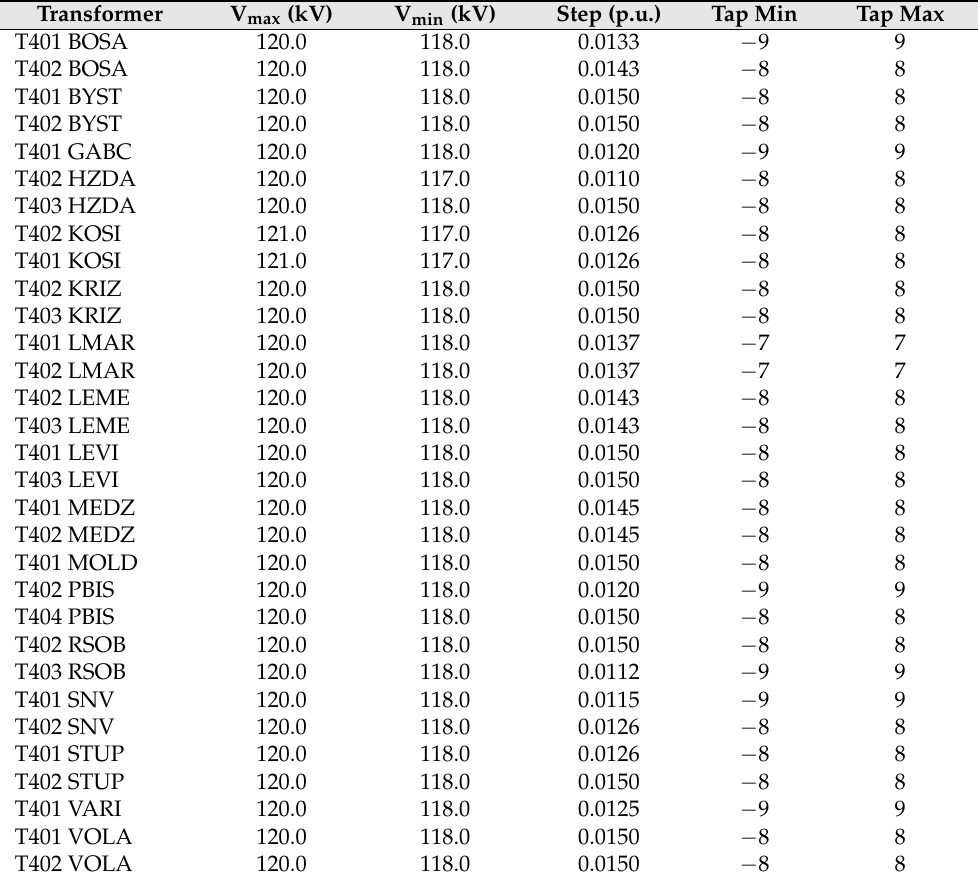
Table 1. List of 400/110 kV transformers with AVR control.